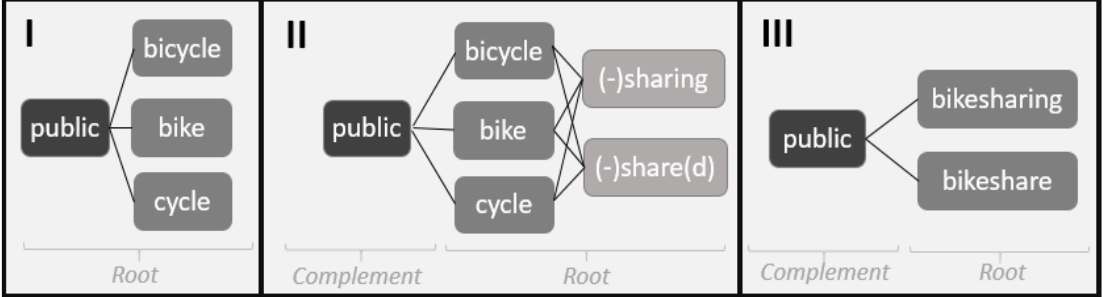
Figure 1. Terms combinations referring to BSS in the